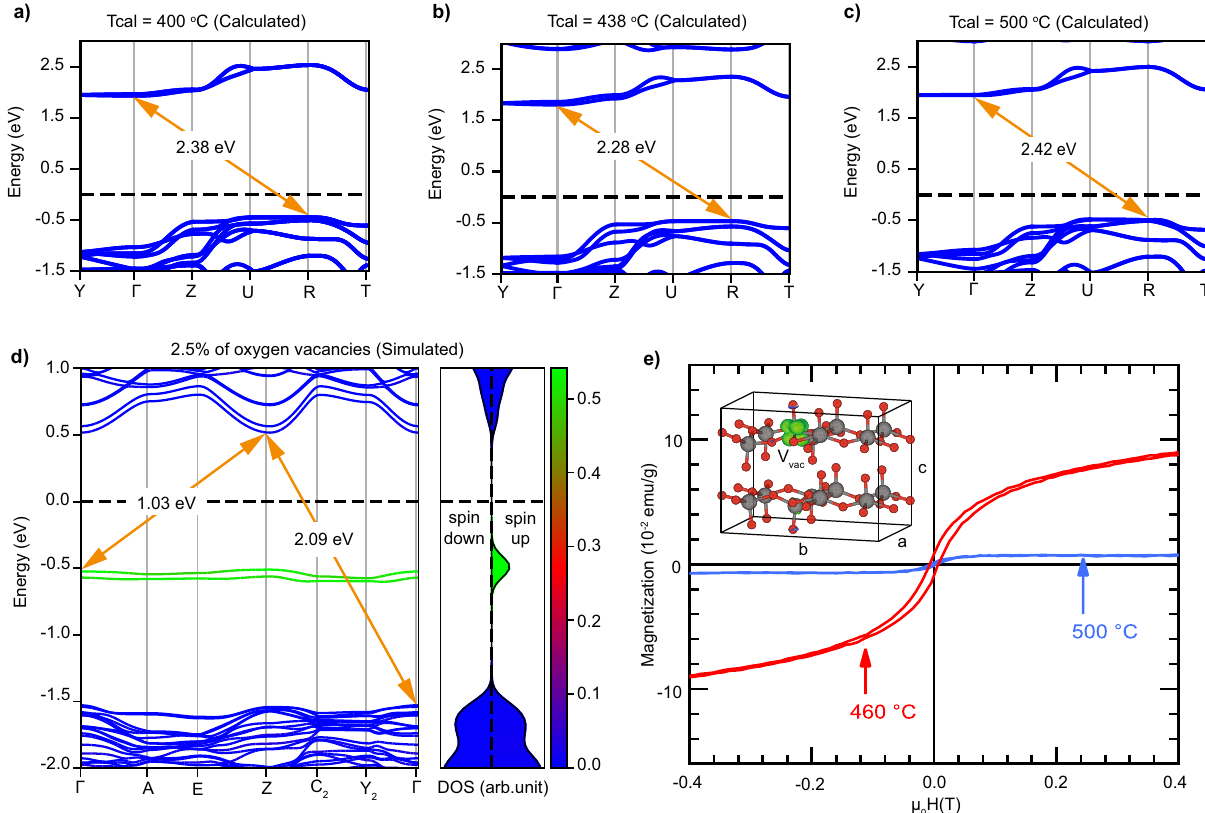
Figure 3. Electronic structures and magnetic measurements. ( a – c ) Representative DFT band structures calculated from Rietveld-refined structures at different T CAL . ( d ) Simulated band structure and density of states of the 2.5% oxygen-deficient system, projected onto V vac d orbitals. The color bar indicates the contributions of the d orbitals. When oxygen vacancies are considered, a spin-polarized interband state appears, which reduces the band gap. ( e ) VSM measurements at T CAL = 460 and 500 °C, which indicate that the NPs have a ferromagnetic-like behavior. The inset in ( e ) corresponds to the relaxed crystal structure of the 2.5% oxygen- deficient system and its spin density as a green surface. This spin density was localized at the vanadium atom which lost its vanadyl O1